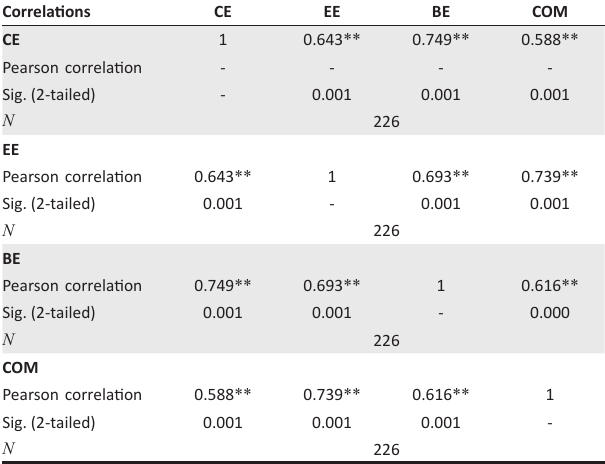
TABLE 2: Correlation analysis.